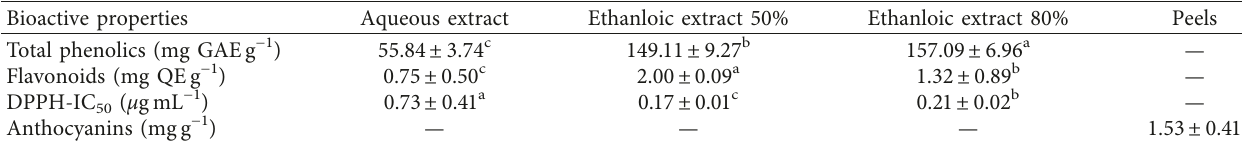
Table 4: Bioactivity of the compounds in different samples.